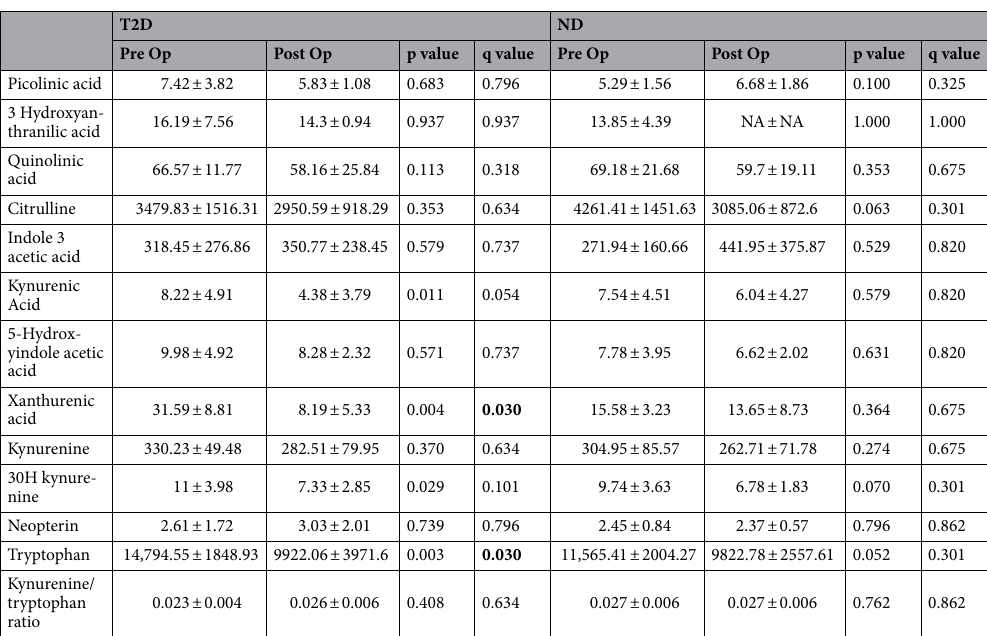
Table.5. Effect of surgery by T2D subgroup on measured metabolites. q values were generated using the Benjamini and Hochberg method to control the false discovery rate (FDR). Units of all of metabolites displayed—ng/ml. KTR expressed as a ratio. Significant values are indicated by bold type.